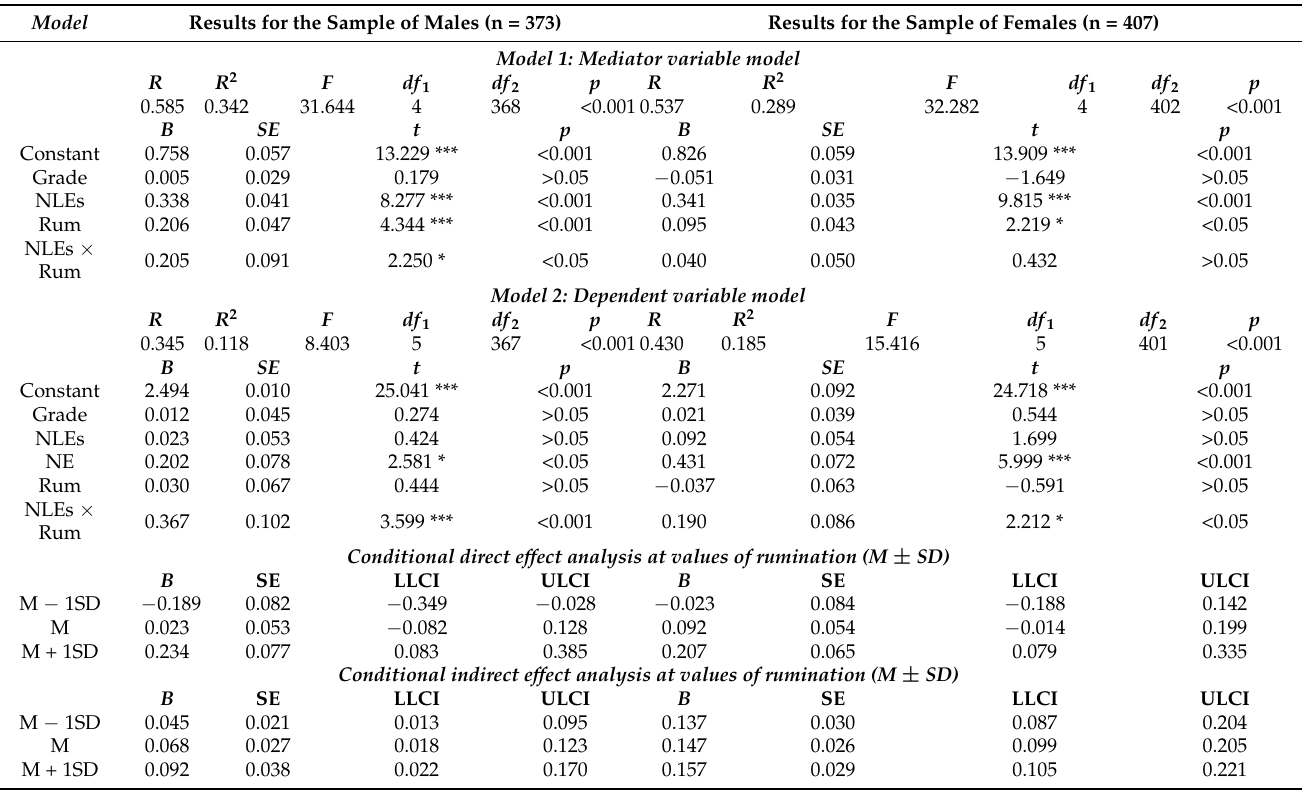
Table 3. Regression results for the conditional indirect effects (moderated